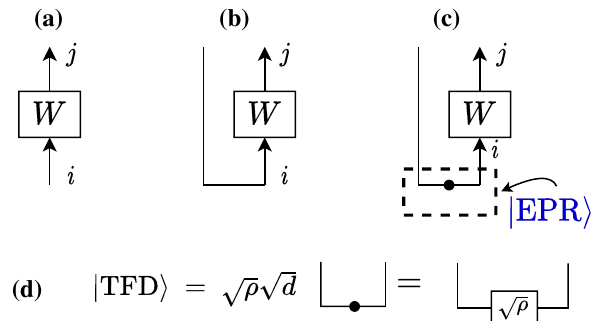
Fig. 5 Operator-state correspondence in diagrammatic form. a An operator W is represented by an ingoing and an outgoing index. b In the state representation both the ingoing and outgoing index are treated similarly and each of them denote a basis state in the two copies of the Hilbert space. c The state | W (cid:7) is related to the EPR, by the rela- tion Eq. (23), The dashed box denotes the EPR state (24). d The TFD denotes finite temperature generalization of EPR, where the density matrix ρ is the density matrix in either the left or the right Hilbert space, ρ = e − β H / Tr ( e − β H